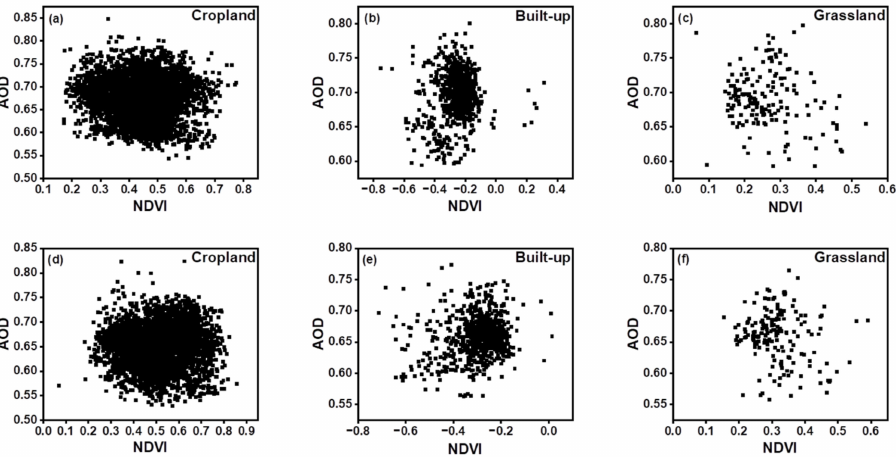
Figure 9. Scatterplot depicting the relationship between NDVI and AOD (Aqua ( a – c ), & Terra ( d – f )) values for different LULC